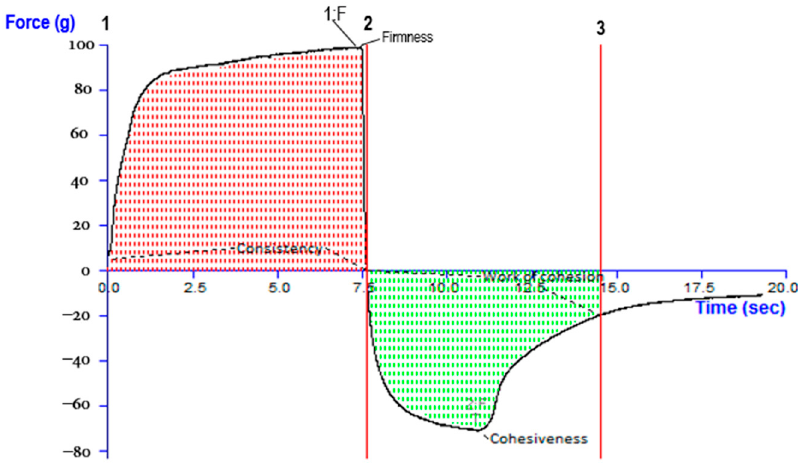
Figure 8. Release kinetics of nanoemulgel observed.